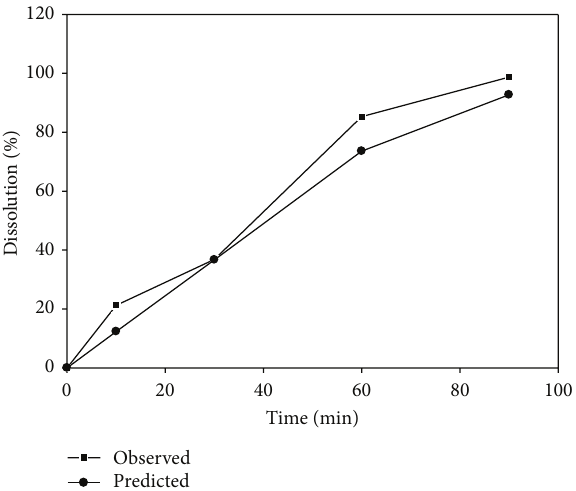
Figure 3: Dissolution profiles of predicted and observed isotreti- noin